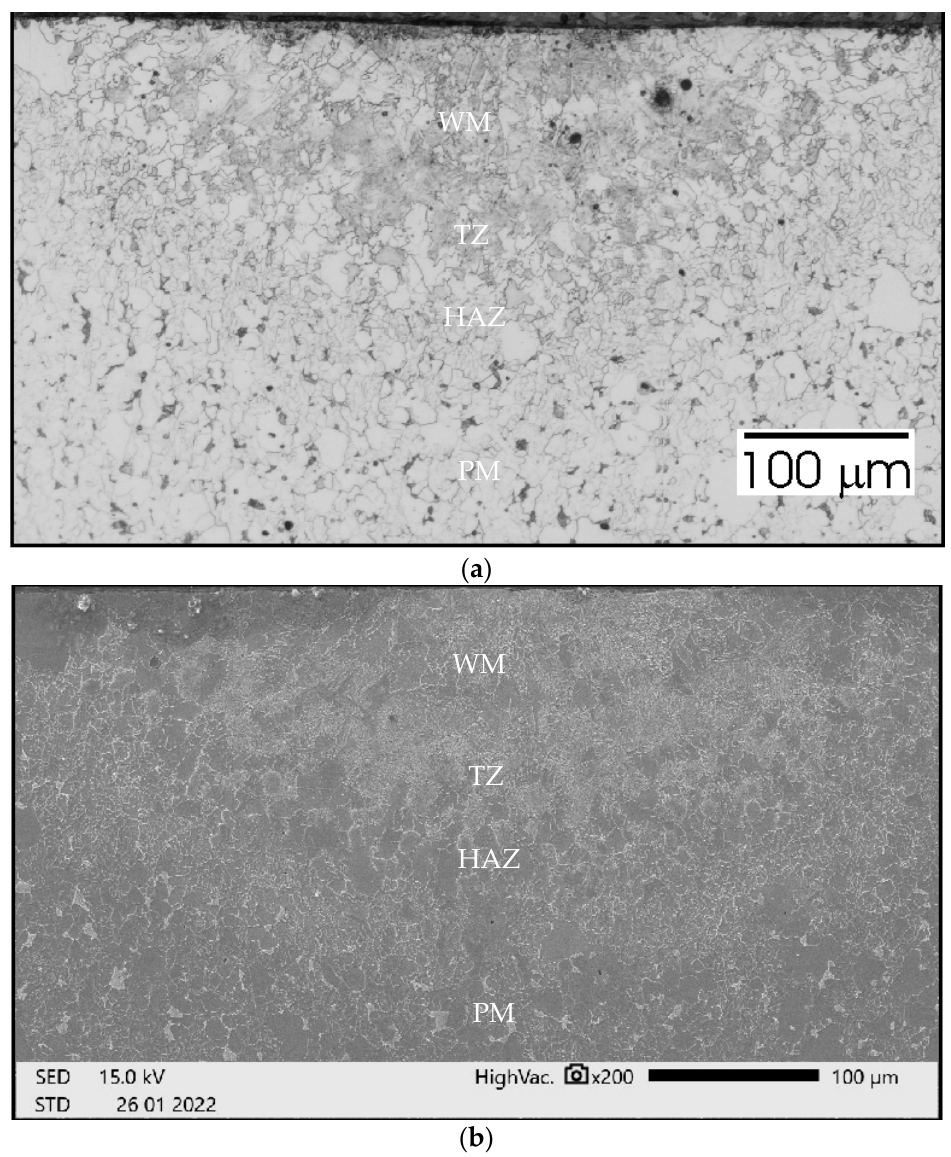
Figure 27. Sample no 5 reached with 110 Hz acoustic vibration delivered parallelly: ( a ) Metallography and ( b ) SEM; PM—parent metal, HAZ—heat affected zone, TZ—transition zone, WM—weld